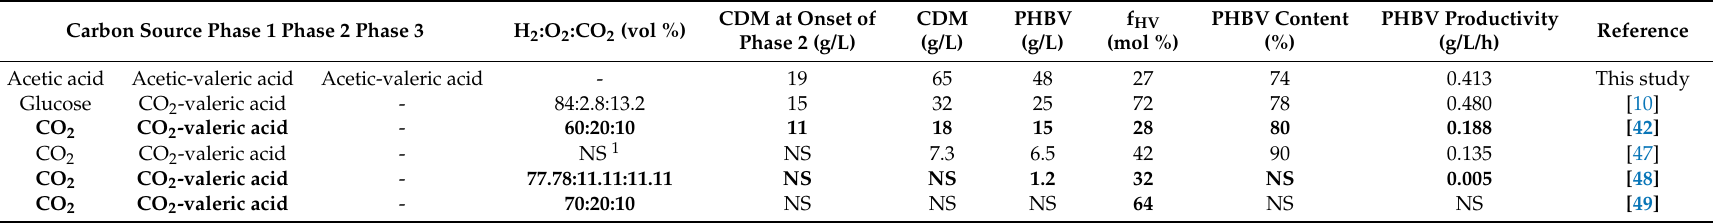
Table 5. Summary of PHBV production in fed-batch fermentations of C. necator using CO 2 or acetic acid as carbon source and continuous stirred-tank reactor (CSTR) in decreasing order of final PHBV concentration. Gas composition ratios that lie within the gas-explosion range (using lower explosion limit of 5.0 vol % O 2 ) are indicated in